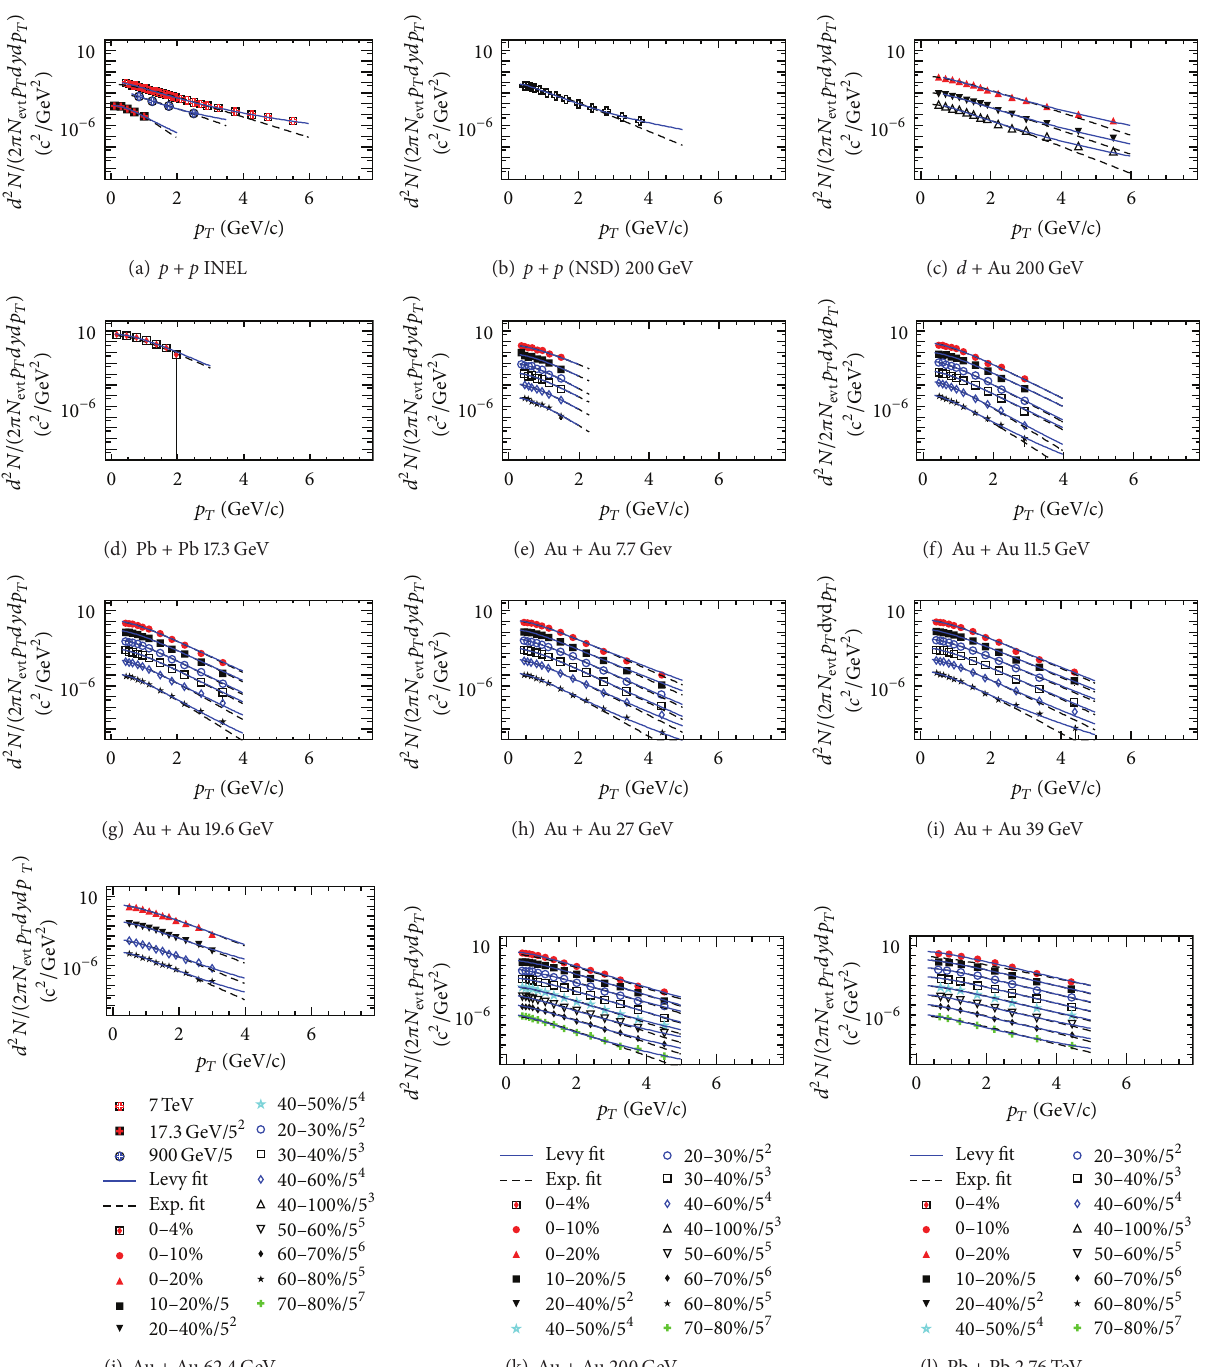
Figure 2: The invariant yield of 𝜙 mesons as a function of 𝑝 𝑇 measured for different system and different centralities at various centre-of-mass energies [16–21]. The black dashed (blue solid) line represents an exponential (Levy) function fit to the